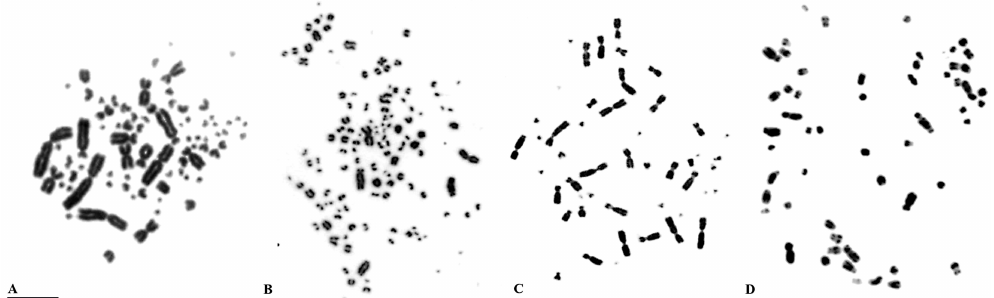
Figure 1. Chromosomal diversity in birds: ( A ) the most typical formulae, with 2n close to 80, such as in Vanellus chilensis (2n = 78); ( B ) an extreme high diploid number, such as Ramphastos tucanus (2n = 112), an atypical low diploid numbers: ( C ) Myiopsitta monachus (2n = 48); and an example of bird of prey ( D ) Spizaetus tyrannus (2n = 68). Scale bar: 5 µ